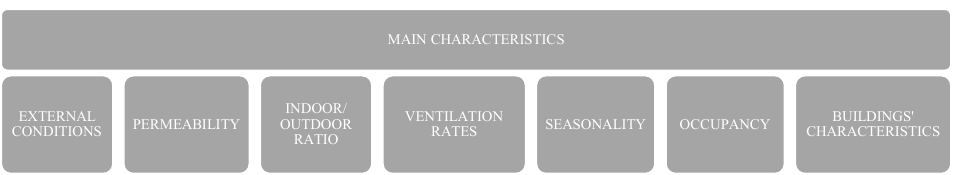
Figure 1. Main schools’ aspects that may influence IAQ.